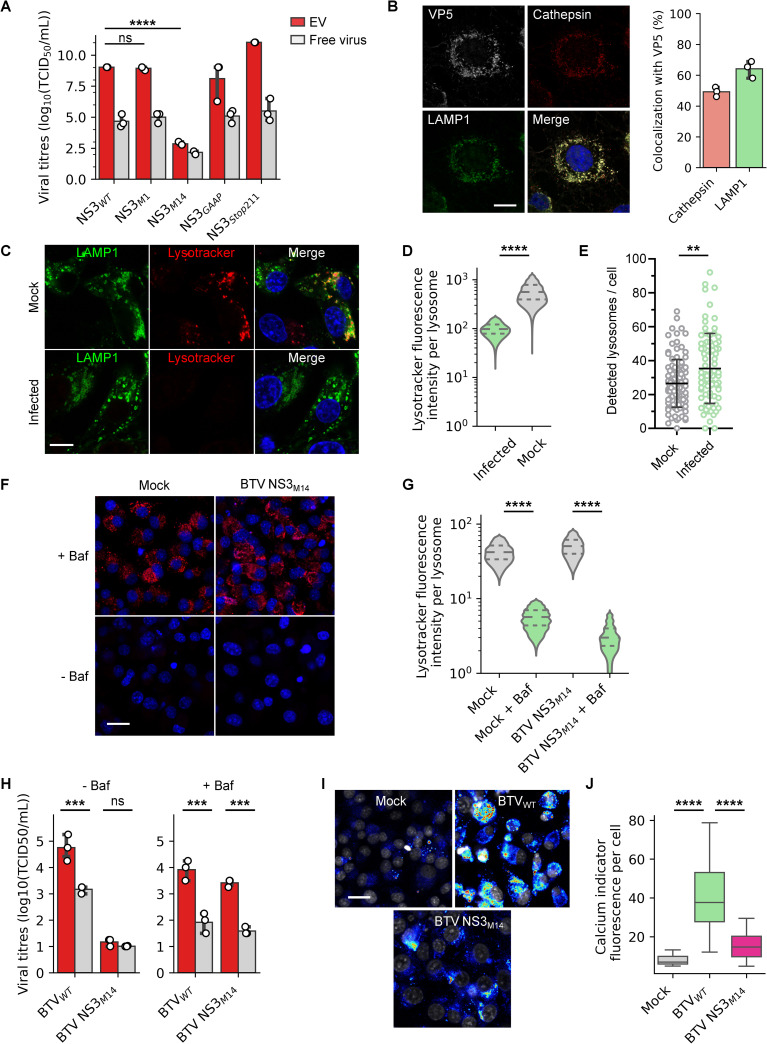
Infectious EVs are derived from lysosomal compartments.(A) Infectivity of the EVs and free virus particles fractions, released from sheep cells infected with different BTV virus with a mutation in the NS3 protein. Data are presented as mean ± SD. Each point indicates the value of independent replicates (N = 3, unpaired t-test, ns p>0.05, ****p<0.0001). (B) Microscopy images of sheep cells infected with BTV NS3M14 and labelled with anti LAMP1, VP5 and pan-cathepsin antibodies. Scale bar: 5 μm. Right panel show the percentage of VP5 co-localising with cathepsins. (C) Microscopy images of mock and BTVWT infected sheep cells (MOI = 10) expressing fluorescent fusion protein LAMP1-GFP (green), in presence of an acidic compartment fluorescent marker (red). Scale bar: 5 μm. (D) Fluorescence intensity of the acidic compartment fluorescent marker detected for each lysosome, in BTVWT or mock infected sheep cells. Violin plots depict min to max values of fluorescence intensity, while the horizontal lines indicate medians (solid lines) and quartiles (dashed lines) (N = 4; unpaired t-test, ****p<0.0001). (E) Average numbers of lysosome/cell in BTVWT infected and mock sheep cells. Data are presented as mean ± SD. Each point indicates the values of each analysed cell (N = 4, unpaired t-test, **p<0.01;). (F) Microscopy images of mock and BTV NS3M14 infected sheep cells (MOI = 10) in presence or not of bafilomycin A1, and an acidic compartment fluorescent marker (red). Scale bar: 20 μm. (G) Fluorescence intensity of the acidic compartment fluorescent marker detected for each lysosome, in BTV NS3M14 or mock infected sheep cells with bafilomycin A1 or not. Violin plots depict min to max values of fluorescence intensity, while the horizontal lines indicate medians (solid lines) and quartiles (dashed lines) (N = 3; unpaired t-test, ****p<0.0001). (H) Infectivity of the EVs and free virus particles fractions, released from sheep cells infected with BTVWT or BTV NS3M14 in presence (right) or absence (left) of bafilomycin A1. Data are presented as mean ± SD. Each point indicates the value of independent replicates (N = 3, unpaired t-test, ns p>0.05, ***p<0.001). (I) Microscopy images of mock, BTVWT and BTV NS3M14 infected sheep cells (MOI = 10) in fluorescent calcium levels indicator (low relative fluorescence in blue and high relative fluorescence in red). Scale bar: 20 μm. (J) Fluorescence intensity of the calcium indicator in mock, BTVWT and BTV NS3M14 infected sheep cells. Box plots depict min to max values of fluorescence intensity, while the horizontal lines indicate medians and quartiles (N = 3; unpaired t-test, ****p<0.0001).